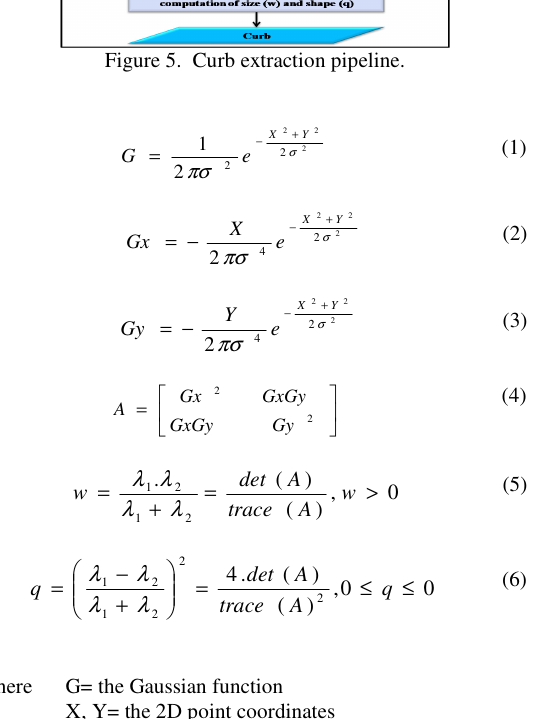
Figure 5. Curb extraction